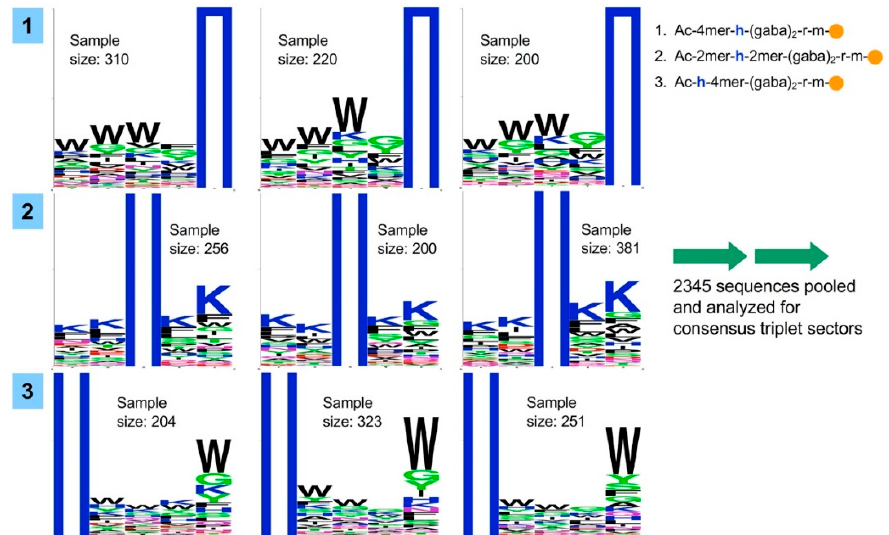
Figure 3. Summary of the screening results of the three His-centric focused libraries against C-peptide (panels 1–3). The twin blue bars in positions 5 (row 1), 3 (row 2), and 1 (row 3) correspond to His. The